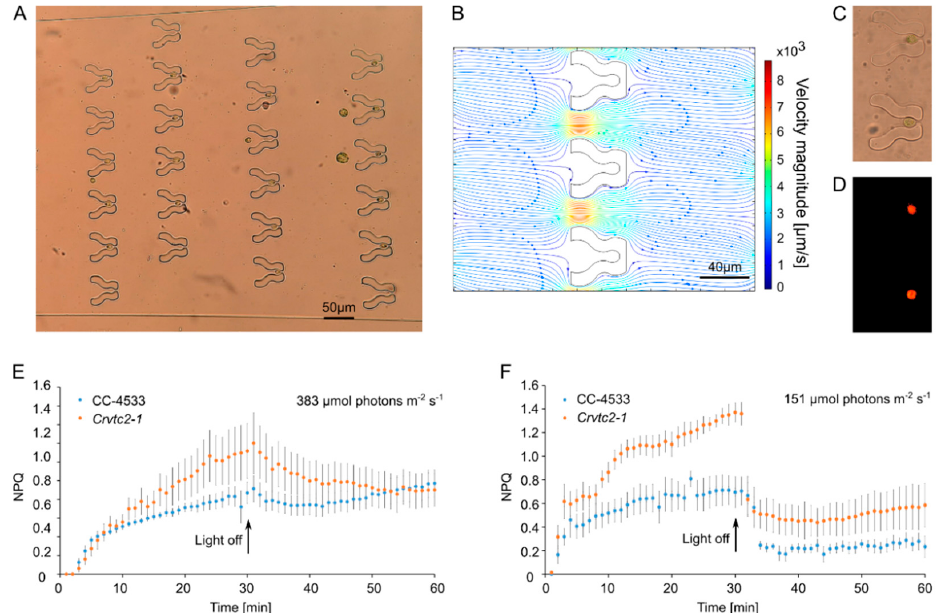
Figure 2. Capturing C. reinhardtii cells and non-photochemical quenching (NPQ) measurements in the “Tulip” microfluidics platform. ( A ) About 70% of the traps are occupied by single cells in the device. Images were taken using a Fluar 20×/0.75 objective. ( B ) Computational modeling of the flow when the outlet is blocked by a cell. The density of the streamlines and the color code indicate the velocity magnitude. ( C ) Bright-field microscopy image of the trapped cells. Images were taken using a Plan-Neofluar 63×/1.25 Oil objective. ( D ) Maximum Chl a fluorescence (F M ) measurement of the captured cells in the “Tulip” device, taken by the Microscopy version of Imaging PAM and using a Plan-Neofluar 63×/1.25 Oil objective. ( E ) NPQ measurements on individual wild-type (CC-4533) and ascorbate-deficient Crvtc2-1 cells, grown and measured in TAP medium at about 383 µmol photon m − 2 s − 1 . ( F ) NPQ measurements on individual wild-type (CC-4533) and ascorbate-deficient Crvtc2-1 cells, grown and measured in HSM medium at about 151 µmol photons m − 2 s − 1 . The results represent an average of five to seven measurements with their standard errors.